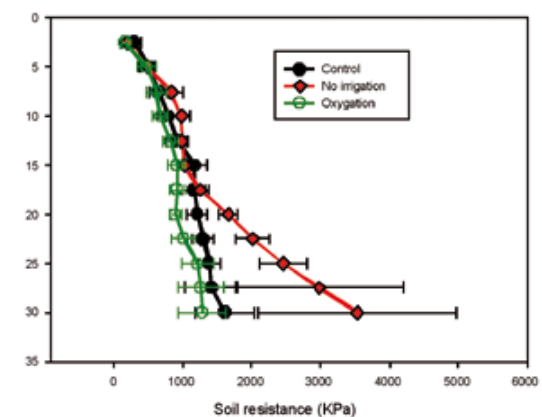
Fig. 7 - Soil compaction measured in the soil at field capacity at the end of the ratoon crop as influenced by soil depth for oxygation (open circle), control (closed circle), and non-irrigated (closed diamond)